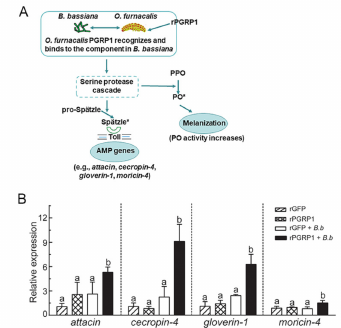
Figure 7. ( A ) Schematic diagram to explain how the injection of PGRP1 and B. bassiana boosted the expression of AMPs. The recognition and binding of O. furnacalis PGRP1 to PAMP in B. bassiana stimulated the activation of serine protease cascades. In one pathway, it resulted in the conversion of PPO into PO, whose activity increased greatly. In the other pathway, it led to the activation of pro-Spätzle, which further bound to the Toll receptor to initiate the expression of AMP genes, including attacin , cecropin-4 , gloverin-1 , moricin-4 , etc. ( B ) Induced expression of AMP genes in O. furnacalis upon the injection of recombinant PGRP1. Purified recombinant PGRP1 or GFP (2 µ g) were injected into the day 0 fifth-instar larvae of O. furnacalis. For some treatments, the larvae were injected again 30 min later with B. bassiana conidia suspension (5 × 10 3 conidia) or PBS as a control. Total RNA samples were isolated from the whole body at 24h after injection for qRT-PCR analysis. O. furnacalis rpL 8 was used as an internal standard to normalize the templates. The bars represent the mean ± S.D. ( n = 3). Bars labeled with different letters are significantly different (analysis using one-way ANOVA followed by Newman–Keuls test, p <